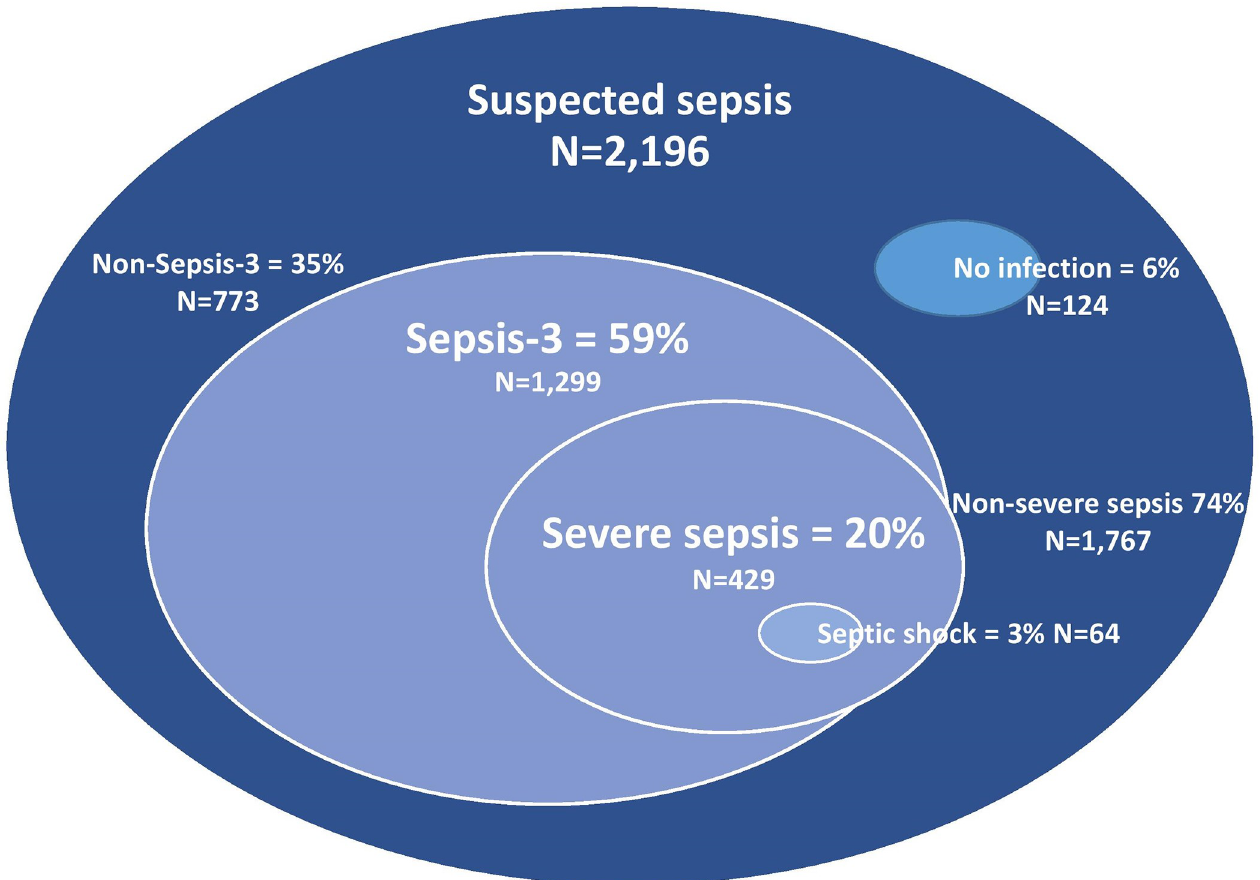
Fig 2. Distribution of severe sepsis and Sepsis-3 sepsis in a cohort of 2,196 consecutive patients with suspected community onset bacterial infection receiving intravenous antibiotic treatment.